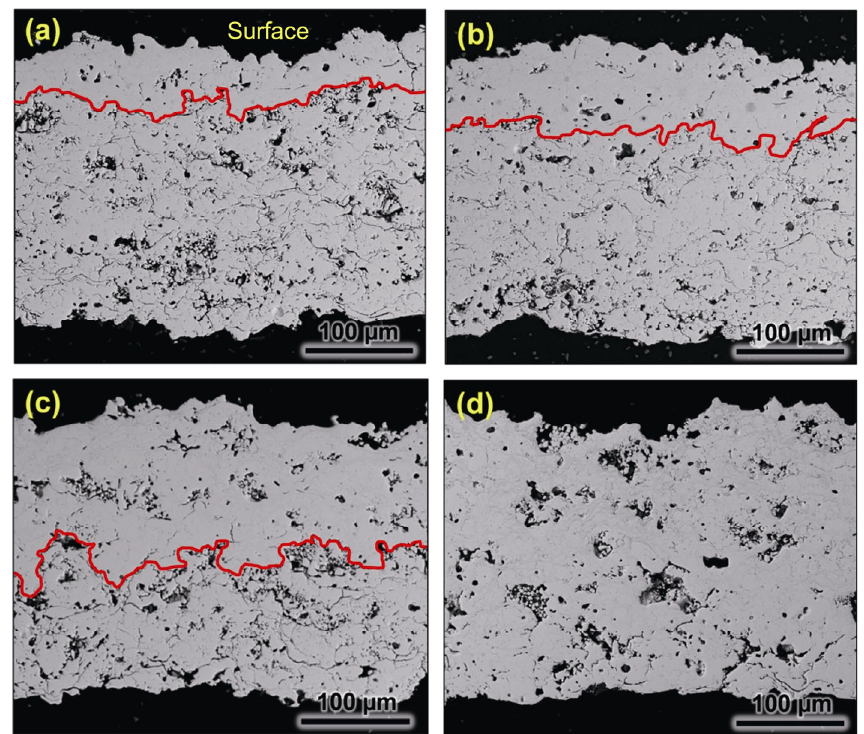
Fig. 51 Cross-sectional SEM images showing the microstructures of YSZ APS TBCs heat-treated at 1250 ℃ for 1 h with CMAS of (a) 0.25, (b) 0.50, (c) 1.0, and (d) 3.0 mg·cm − 2 . Reproduced with permission from Ref. [264], © Elsevier Ltd. 2019.